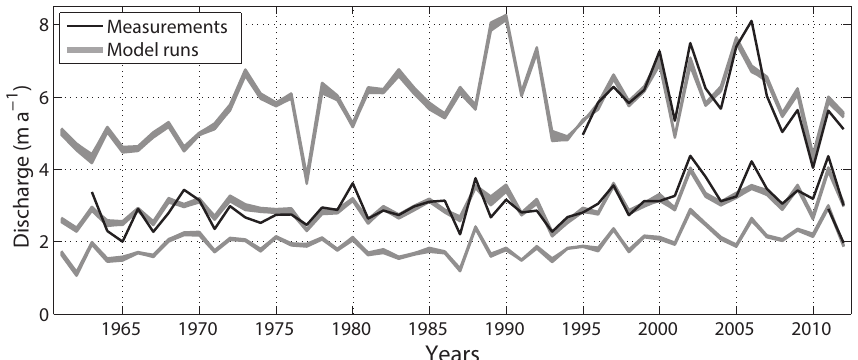
Fig. 7. Mean annual discharge sums for the catchments of Ålfotbreen (upper lines), Nigardsbreen (centre lines) and Storbreen (lower lines) for the period 1961–2012.